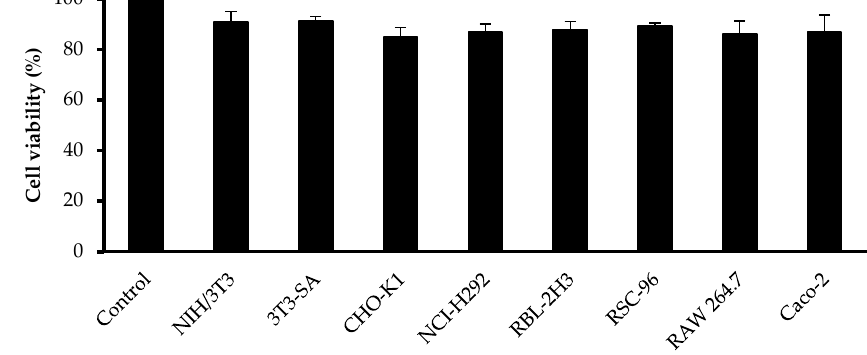
Figure 4. Cytotoxic effect on different cell lines.